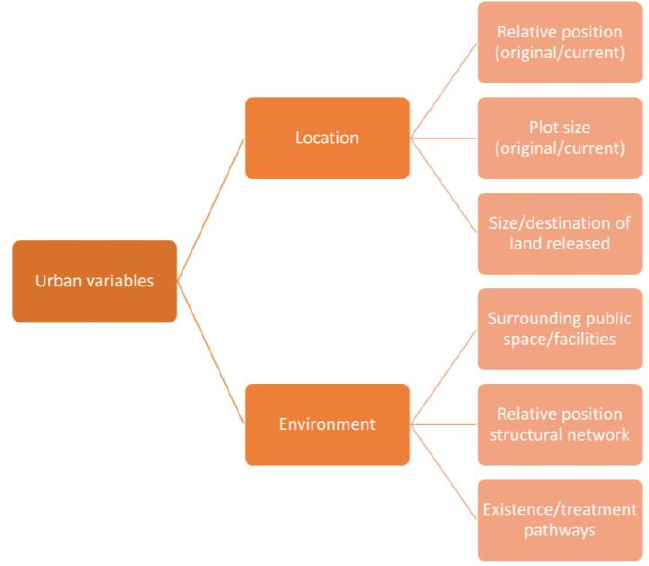
Figure 3. Urban variables analysed. Own elaboration.